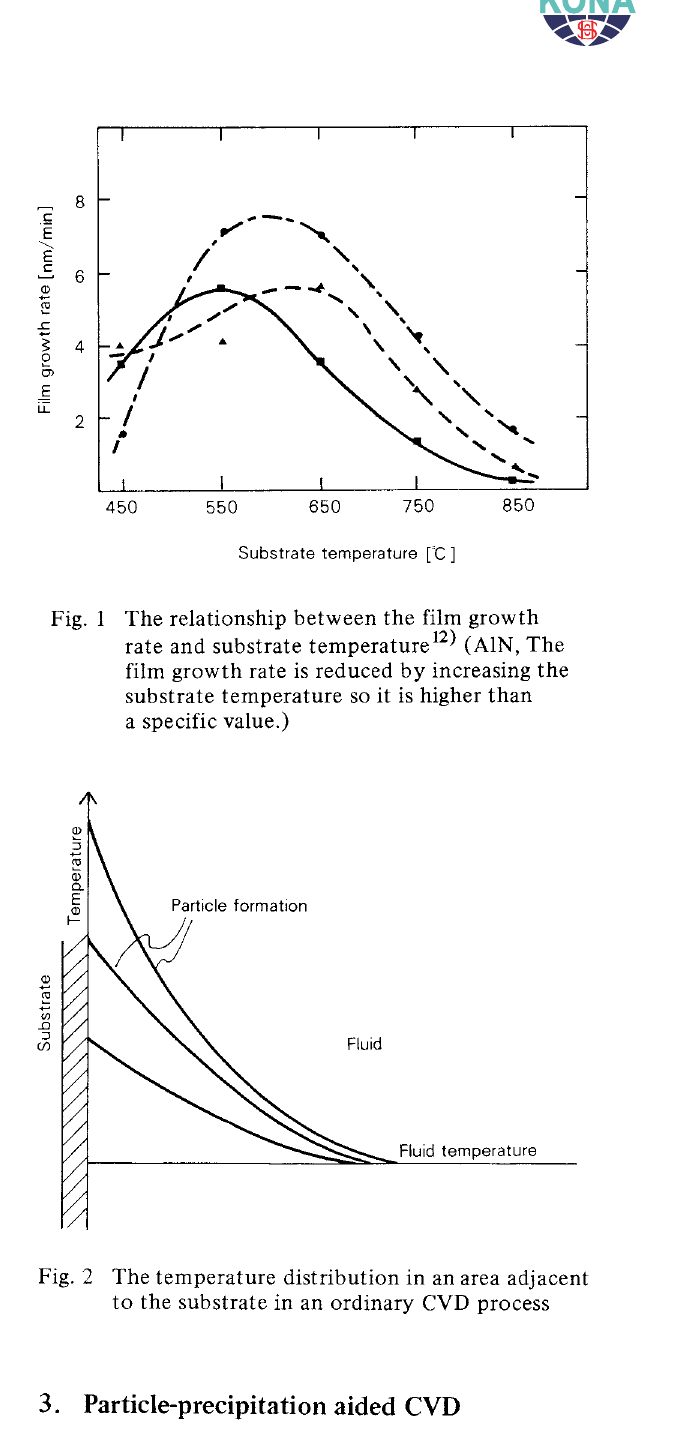
Fig. 2 The temperature distribution in an area adjacent to the substrate in an ordinary CVD